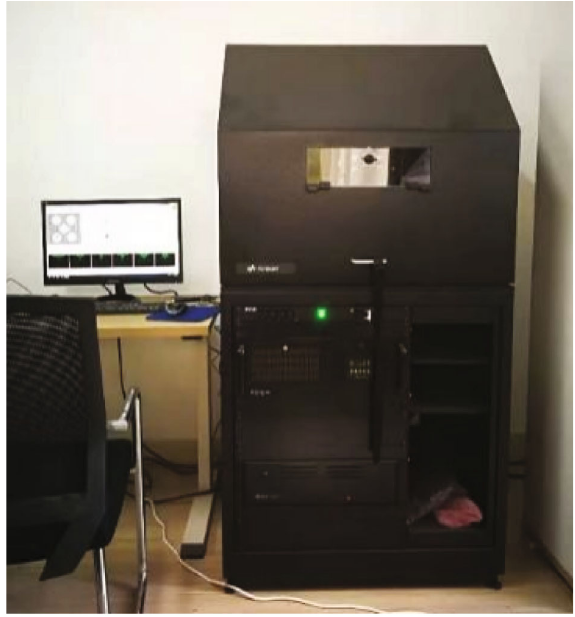
Figure 4: Agilent nanoindenter G200.